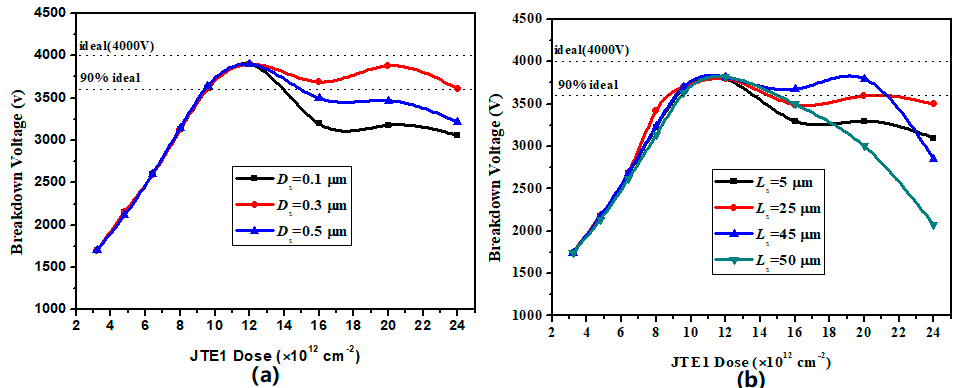
Figure 5. Simulated BV versus ( a ) the depth ( D s ) and ( b ) the length ( L s ) of the Step JTE for Step-DZ-JTE optimization.